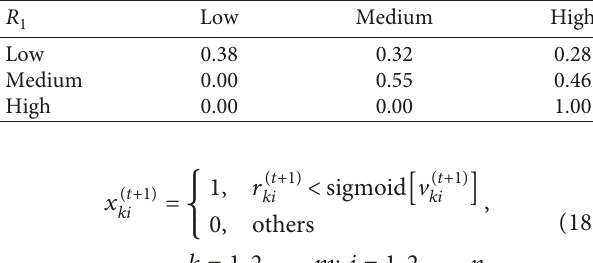
Table 2: State transition matrix of risk R